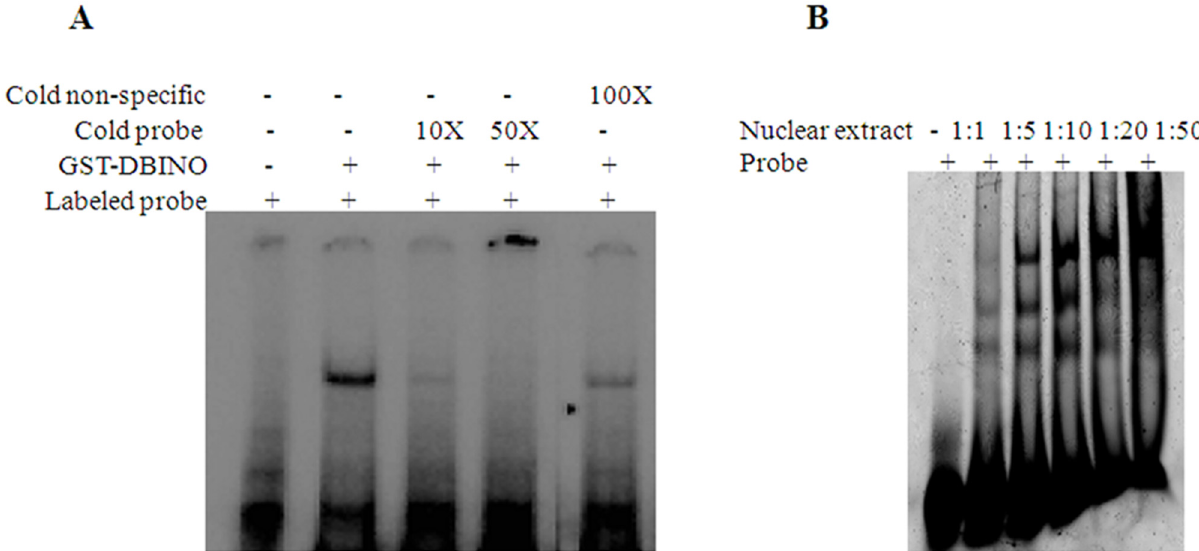
Fig 2. INO80 interaction with SELEX motif. (A) Interaction of GST-DBINO with DNA. (B) Optimization of molar ratio of oligonucleotide: nuclear extract from HEK293T cells for